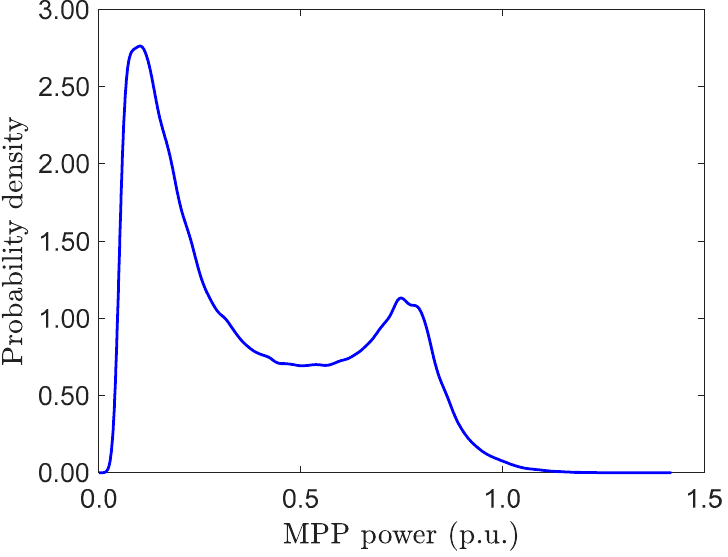
Figure 6. The probability density distribution of the maximum power point (MPP) power of the PV generator normalized to the 31.9 kW standard test conditions (STC) power during the observation period.